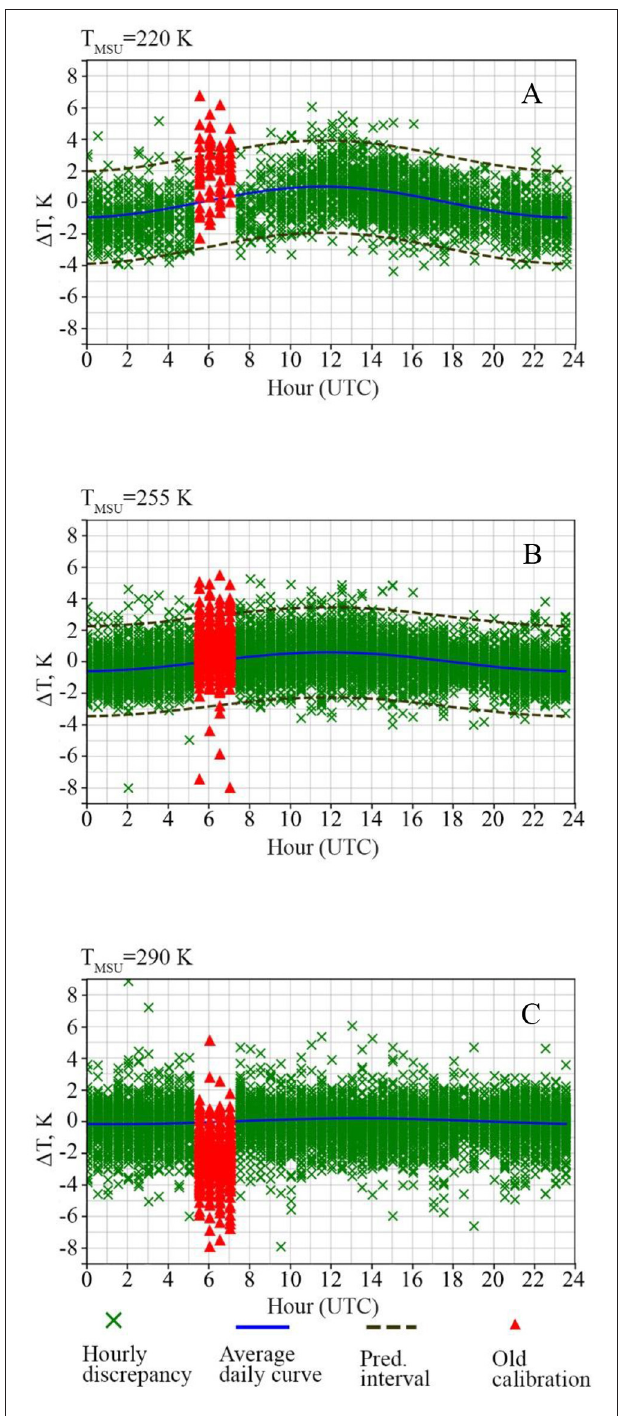
FIGURE 4 | Averaged (during the year 2018) diurnal variation of calibration offsets in MSU-GS channel# 9 for three BTs ( A –220 K; B –255 K; C –290 K).